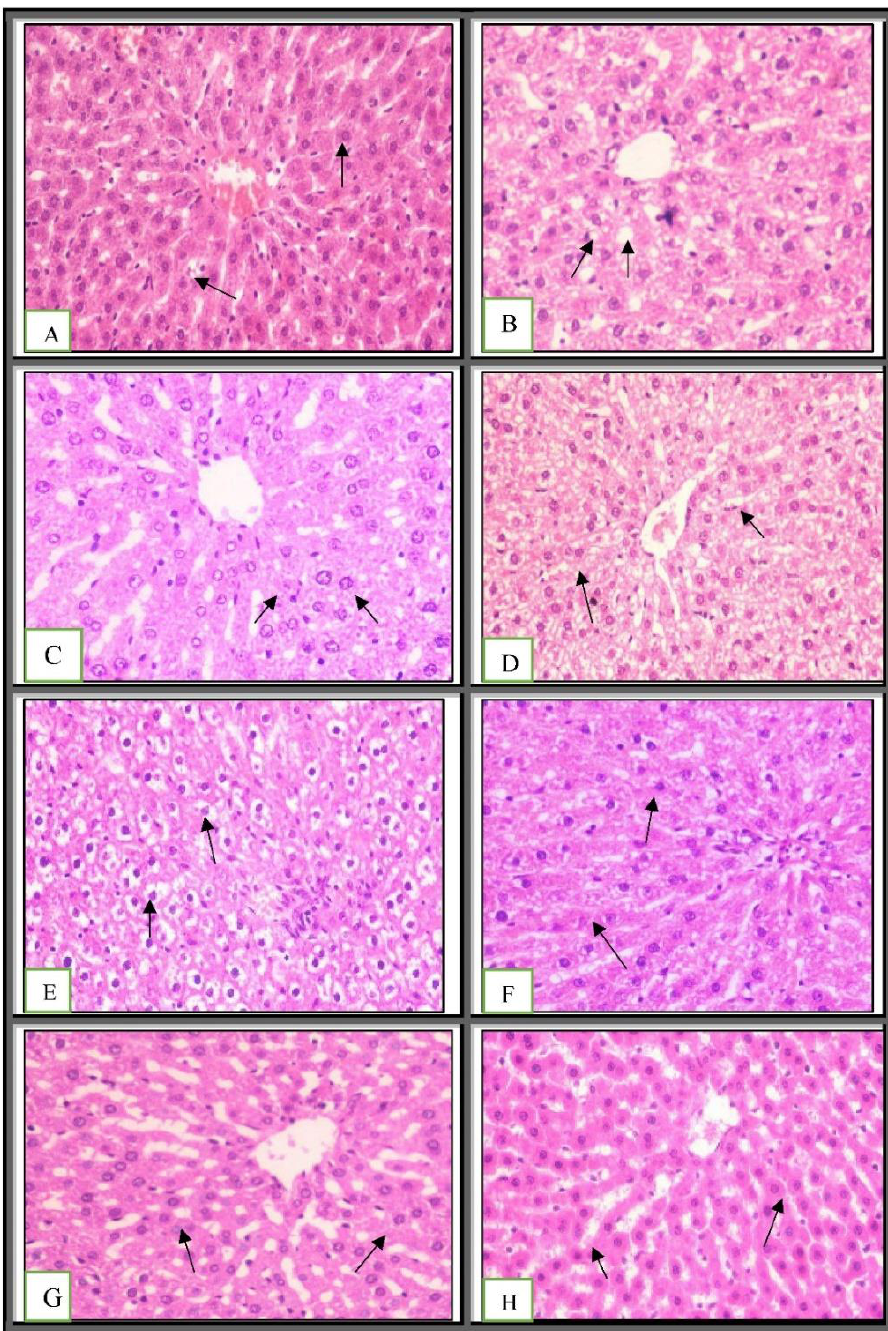
Figure 3. Histopathological examination of hepatic tissue: ( A ) showing normal histological structure of hepatic lobule arrow ; ( B ) showing ballooning and fatty degeneration of hepatocytes arrow (H&E × 400); ( C ) showing mild swelling of hepatocytes arrow ; ( D ) showing ballooning degeneration of hepatocytes arrow (H&E × 400); ( E ) showing ballooning degeneration of hepatocytes arrow ; ( F ) showing swelling of hepatocytes arrow (H&E × 400); ( G , H ) showing no apparent injury by light microscopy arrow (H&E × 400). ( A ) Negative control; ( B ) positive control; ( C , D ) green tea; ( E ) chia seed; ( F ) chitosan; ( G ) probiotic; ( H ) mixture. A 50 µ M bar scale was used for all the tissues.